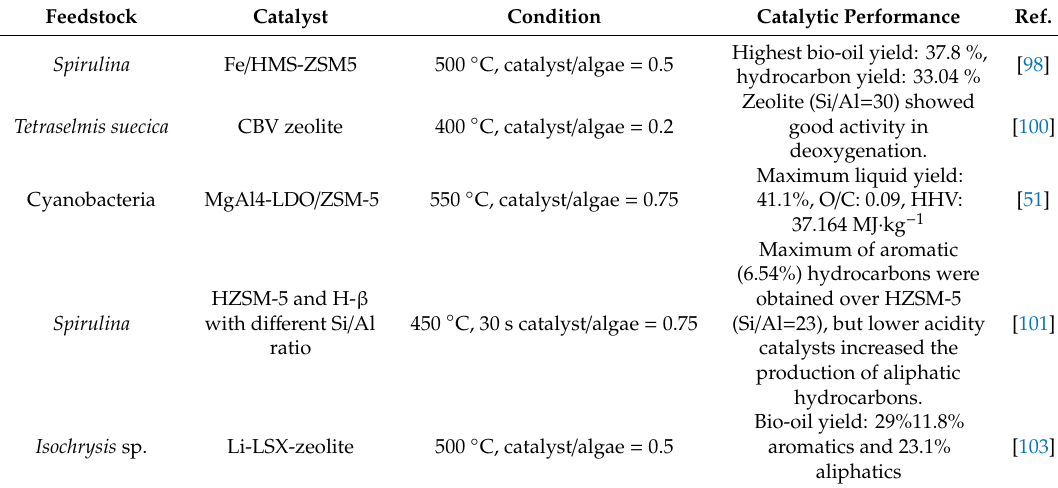
Table 3. Catalytic pyrolysis of algae over